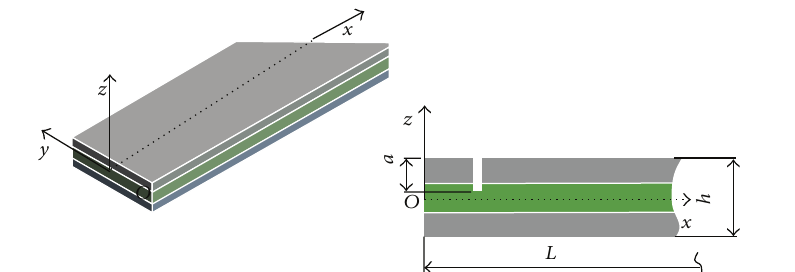
Figure 4: Sandwich beam with damage.